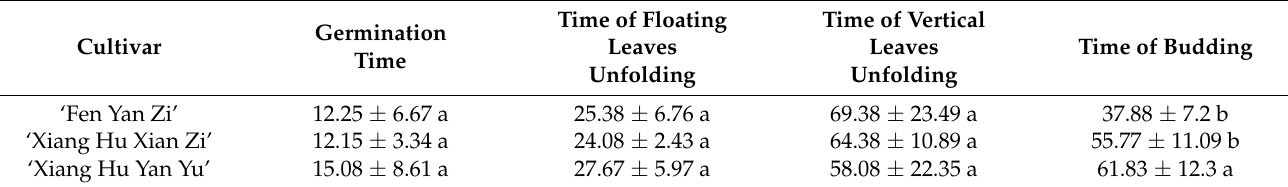
Table 5. Comparison of phenological periods of 3 Nelumbo nucifera cultivars.